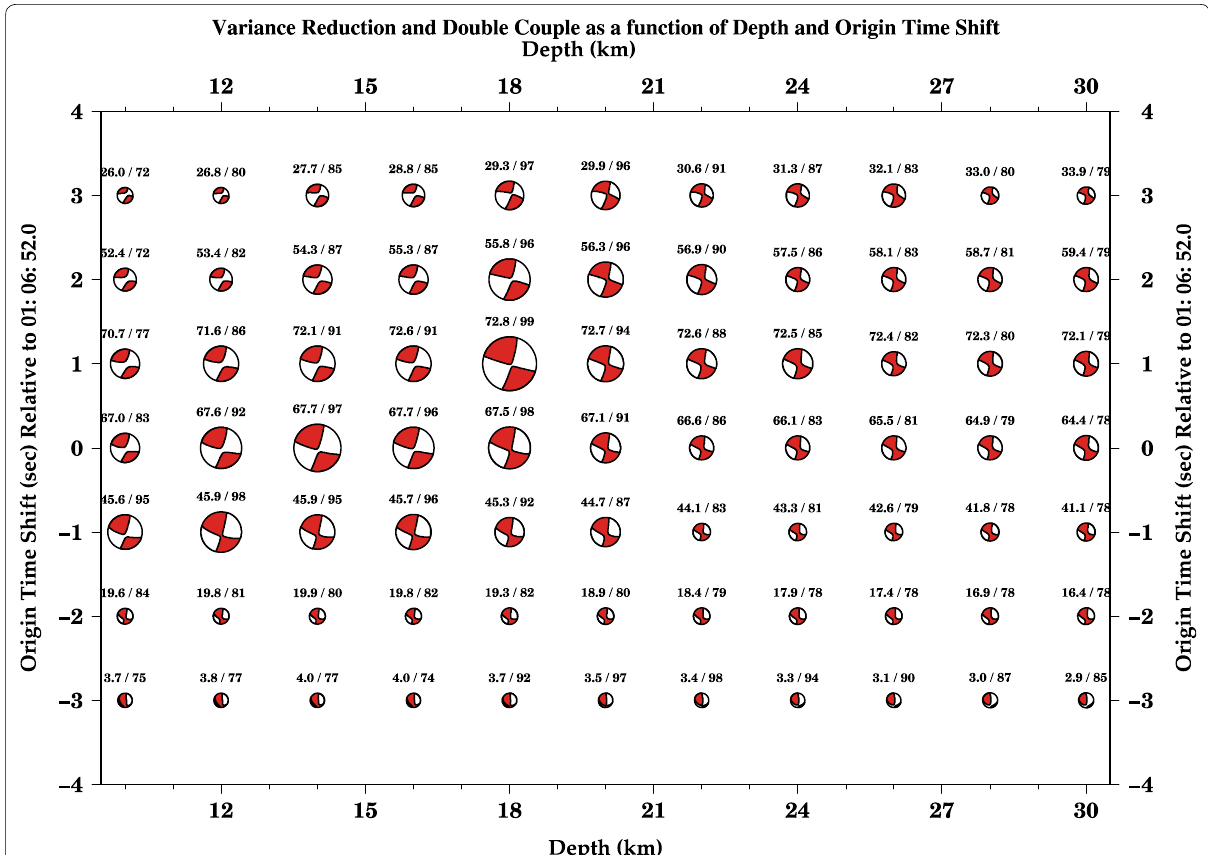
Fig. 5 Plot showing the variance reduction and double‑couple focal mechanisms of the mainshock as a function of focal depths and origin times. In this plot the variance reduction is proportional to the dimension of the beach ball double‑couple mechanism. The optimum origin time is shifted relative to the earthquake origin time of 01 h, 06 min, and 52 s. The optimum solution reveals a focal depth of 18